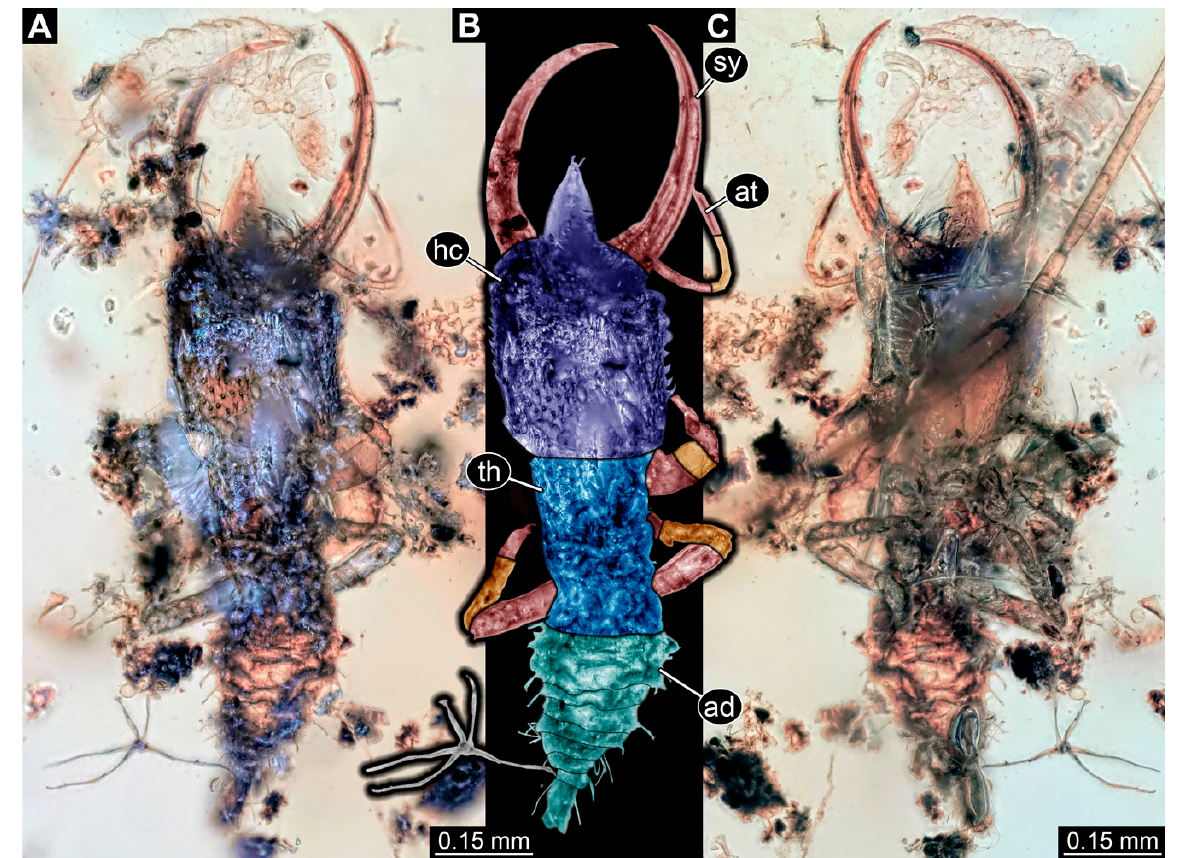
Figure 27. Specimen 92 (PED 2311); Myanmar amber. ( A ) Dorsal view. ( B ) Dorsal view, colour- marked. ( C ) Ventral view. Abbreviations: ad = abdomen; at = antenna; hc = head capsule; sy = stylet; th = thorax.